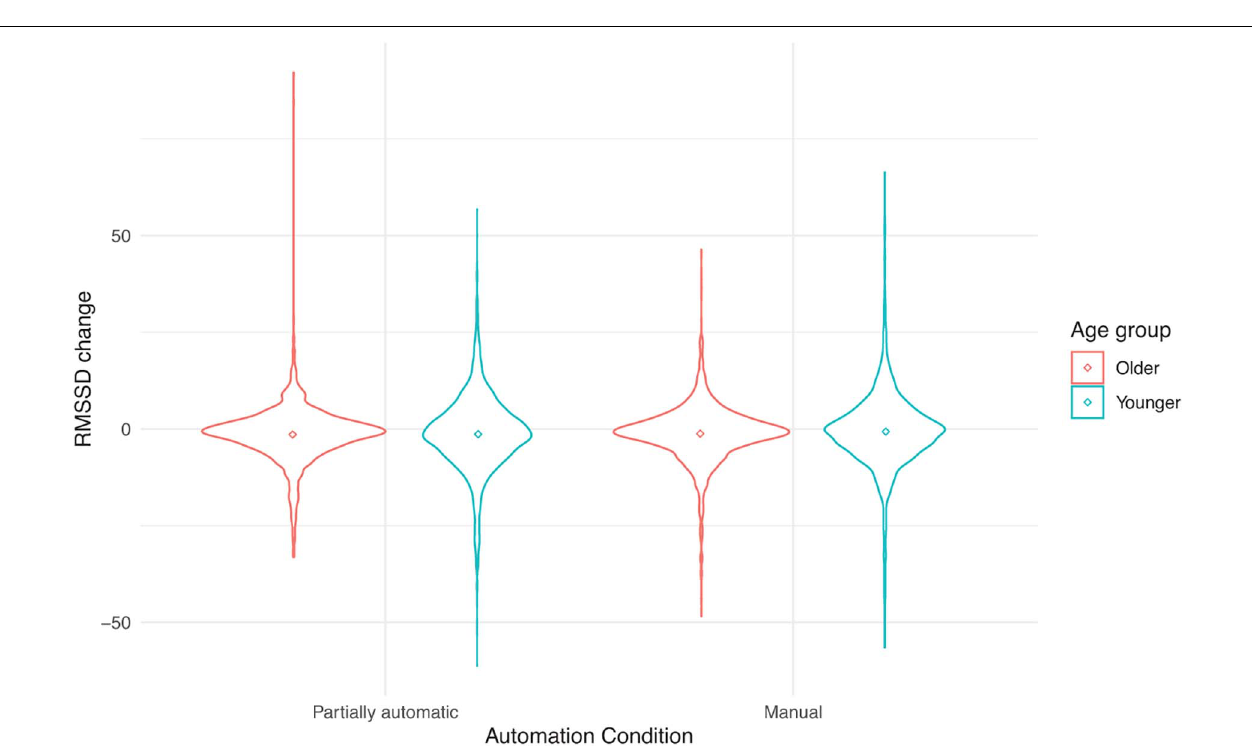
Frontiers in Neuroscience |